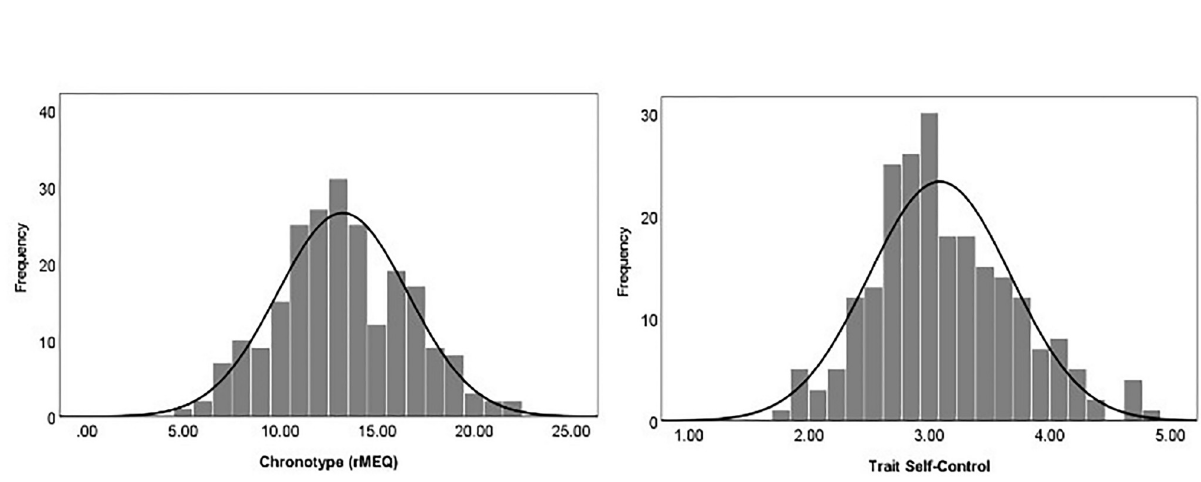
Fig 2. Distributions of chronotype (rMEQ) and trait self-control in the total sample.